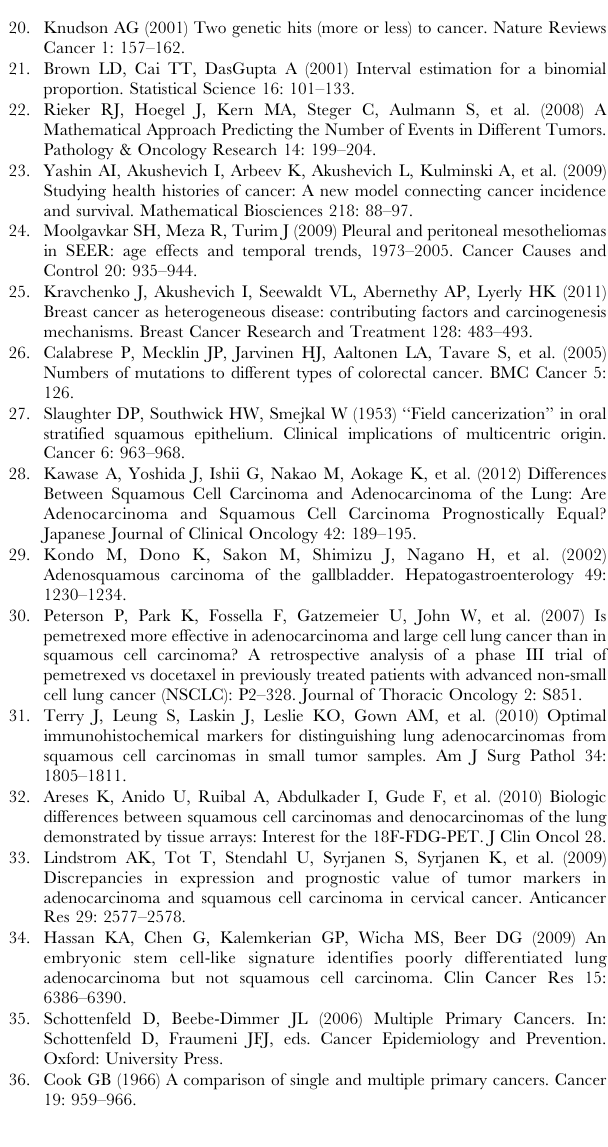
Table S1 Modeling results (i.e. fitting parameters with SE) for selected cancer histotypes model fitting, for male and female white and African-American (AAs)